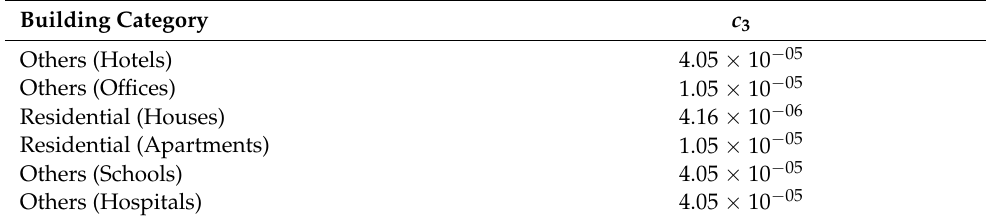
Table 6. Values assumed for the new coefficient c 3 in the improved Barrois